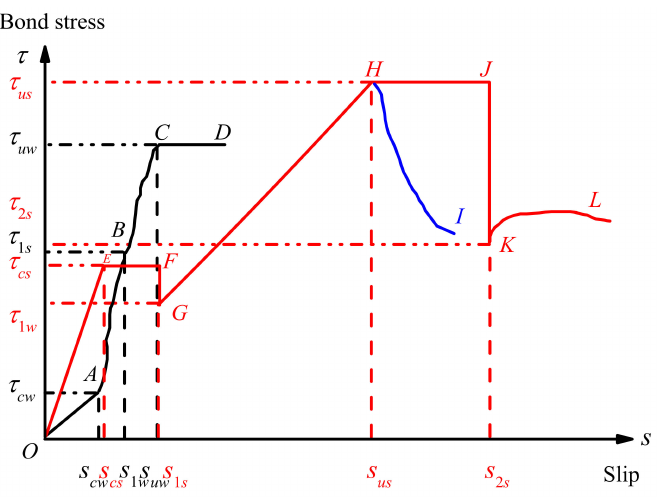
Figure 14. Model of bond stress–slip